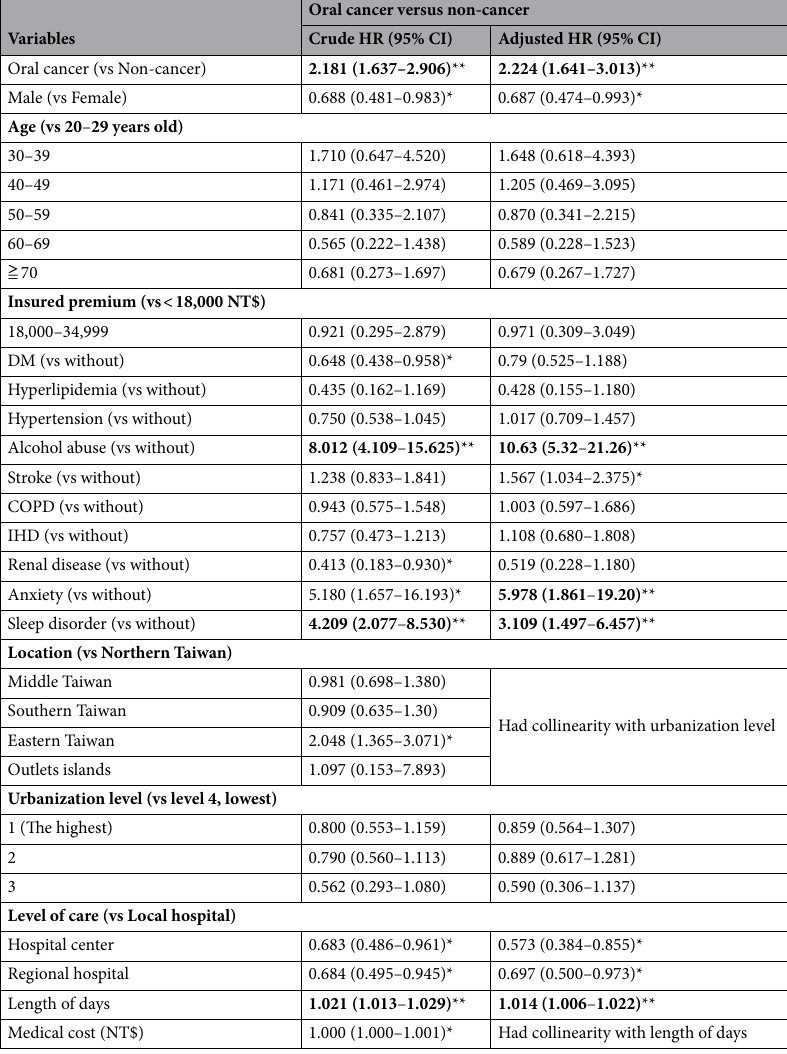
Table 2. Factors of depression by using Cox regression. HR hazard ratio, CI confidence interval, Adjusted HR adjusted variables listed in the Table 1. NT$ New Taiwan Dollars, DM diabetes mellitus, HTN hypertension, COPD chronic obstructive pulmonary disease, IHD ischemic heart disease. *The pair of subsets showed a significant difference at p < 0.05. **The pair of subsets showed a significant difference at p < 0.001.